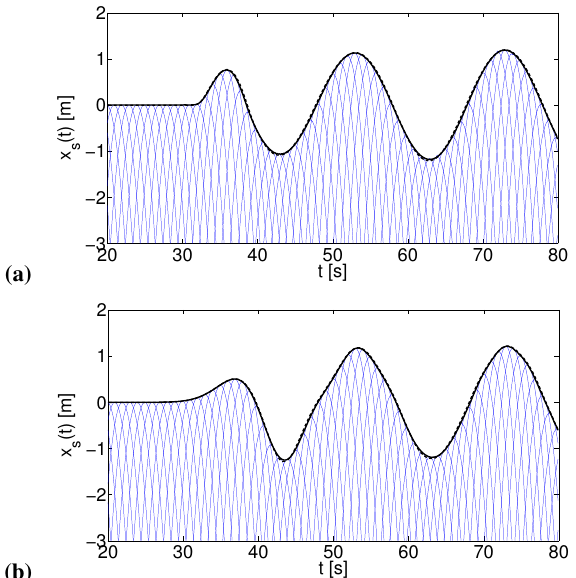
Fig. 11. The shoreline movement of periodic waves for the linear Figure 11. The shoreline movement of periodic waves for the linear model ( a : LSWE, b : LVBM) coupled to the NSWE (dashed line) model ( a : LSWE; b : LVBM) coupled to the NSWE (dashed line), and for the linear model with an EBC implementation (solid line). and for the linear model with an EBC implementation (solid line). Paths of the first-order characteristic curves are shown by the thin Paths of the first-order characteristic curves are shown by the thin lines. lines.